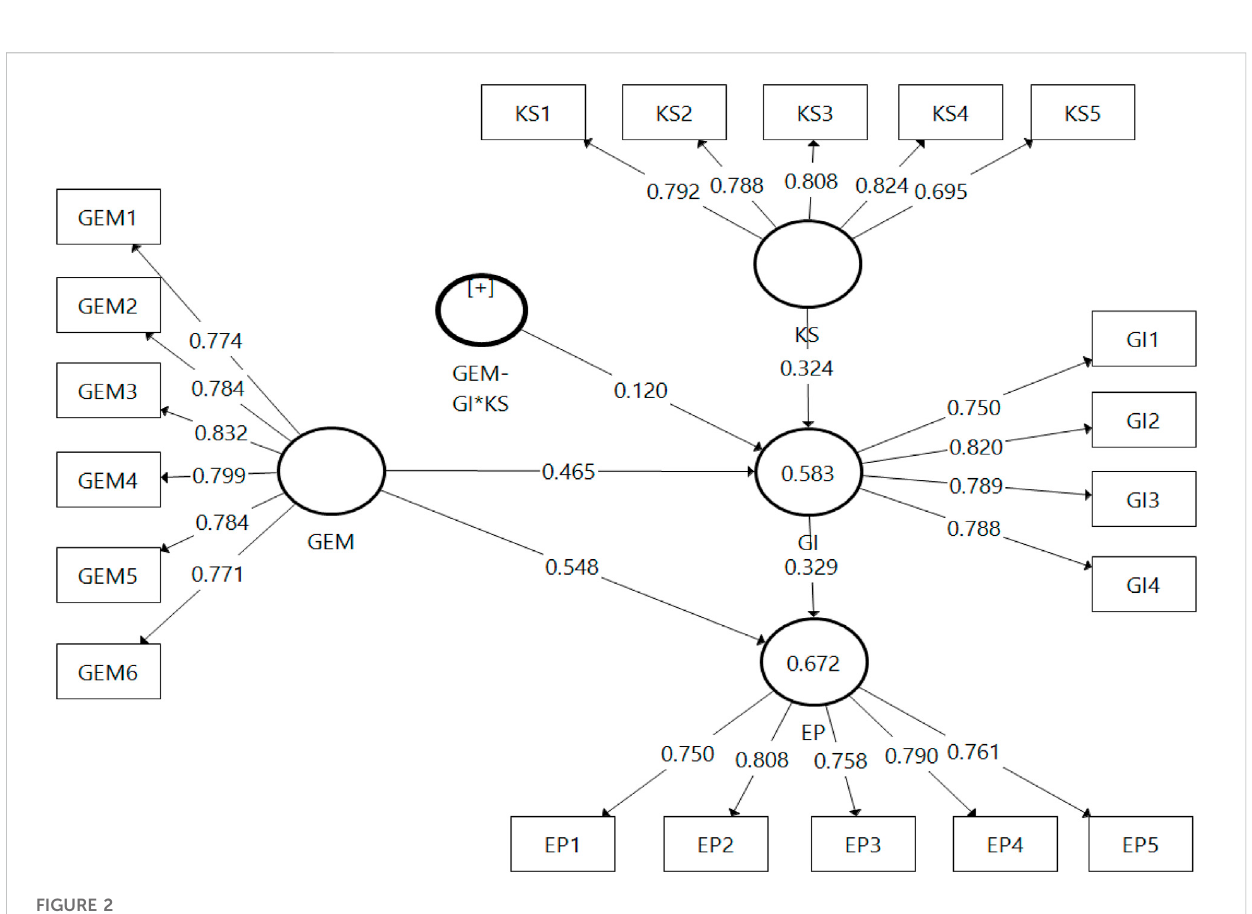
FIGURE 2 Path coef fi cients. Source: Primary